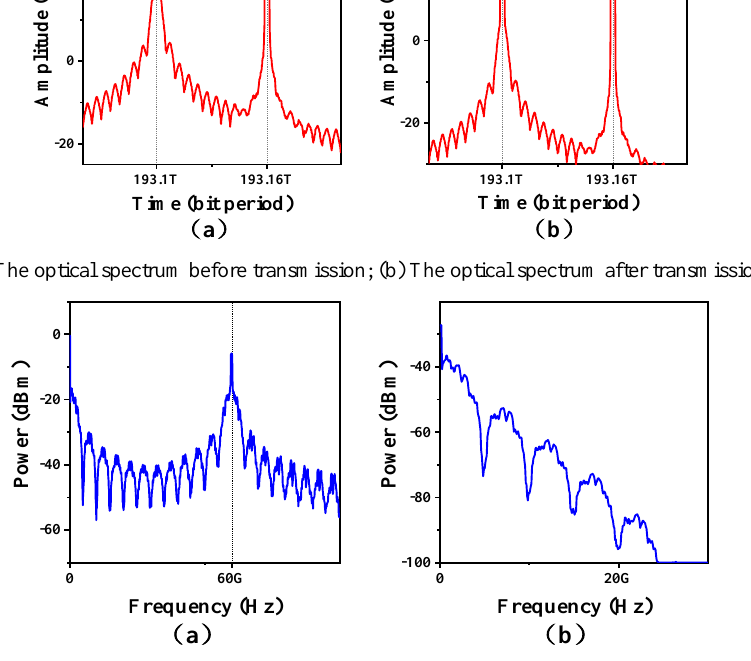
Fig. 4. (a) The RF spectrum after PIN-PD; (b)The RF spectrum after differential